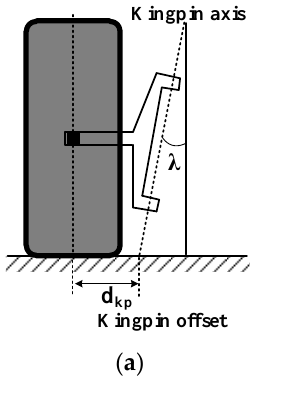
Figure 4. Kingpin and caster ( a ) Kingpin ( b ) Caster .